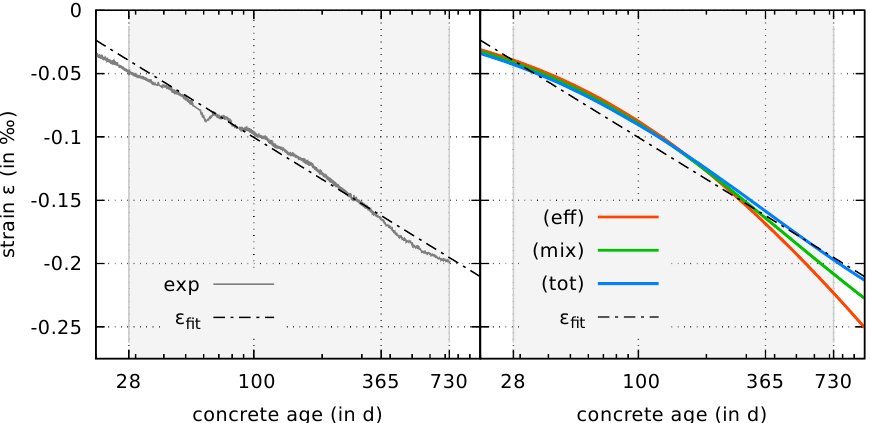
Figure 8. Fitted logarithmic approximation to experimental data from [8,9] ( left ) and comparison to computed evolutions of the autogenous shrinkage strain ( right ). The grey background color indicates the concrete age interval used for